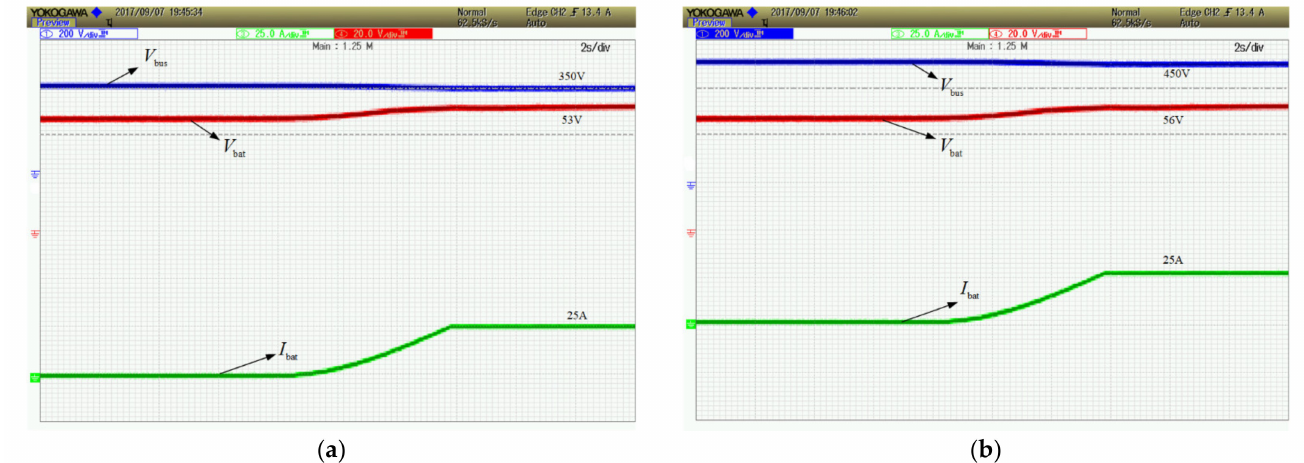
Figure 18. The experiment waveform of the converter under different charging modes and the bus voltages in ( a , b ) are 350V and 450V, respectively.